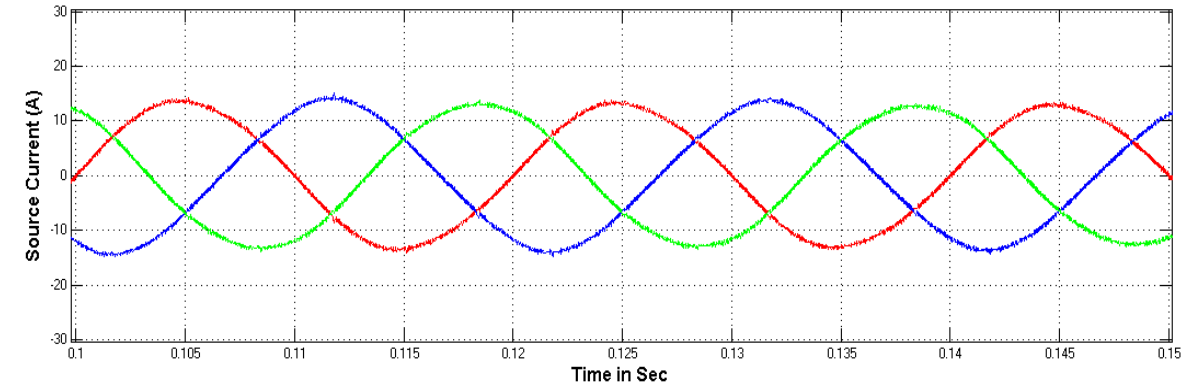
Figure 8. Source Voltage